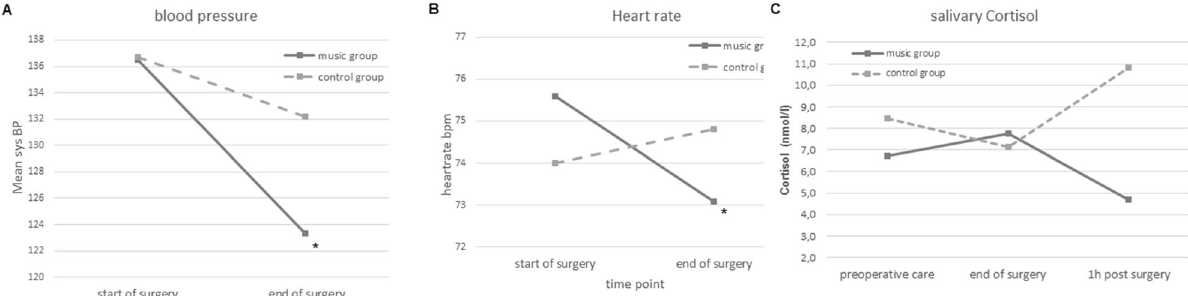
Figure 2. The effect of the music intervention on physiological and endocrinological outcome measures. ( A ) The music group displayed a significant decrease in blood pressure from start to the end of the surgery. ( B ) Heart rate values of the music group reduced significantly from before to the end of the surgery. ( C ) No significant time-group interaction was revealed for salivary cortisol and therefore no post-hoc tests were calculated, however, descriptively the music group shows lover cortisol values 1 h postoperatively. * p <